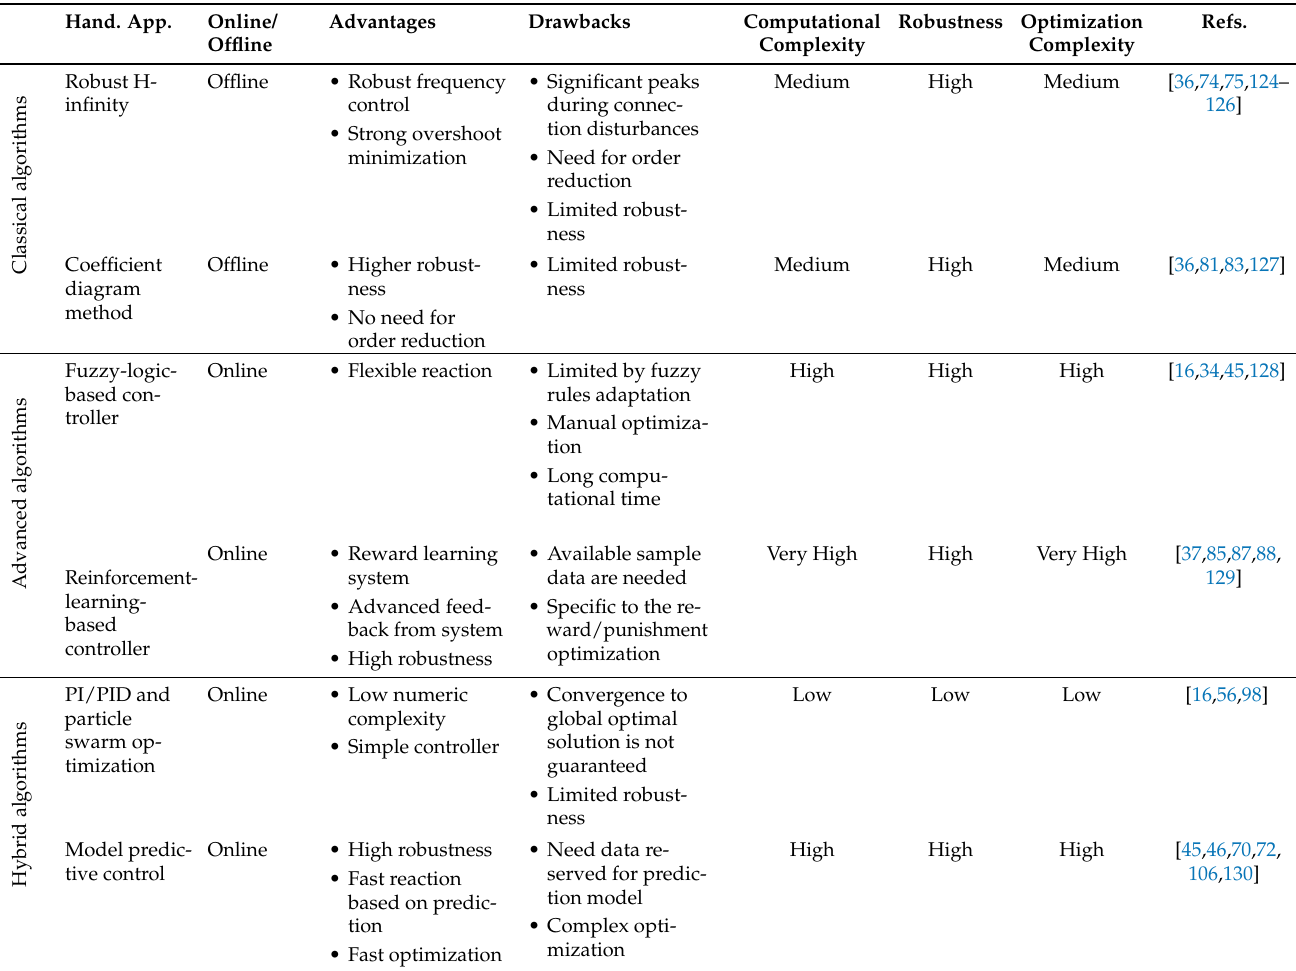
Table 4. Comparison of virtual inertia control algorithms: advantages, drawbacks, and quality criteria. Hand. App. Online/ Advantages Drawbacks Computational Offline